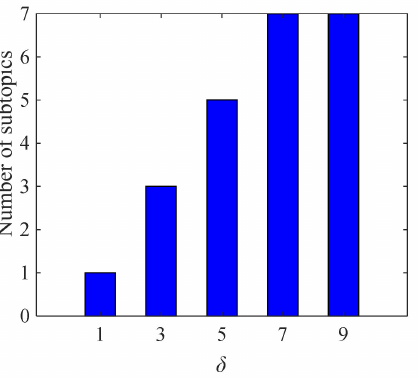
Figure 13. The number of derived subtopics under different information alienation settings.